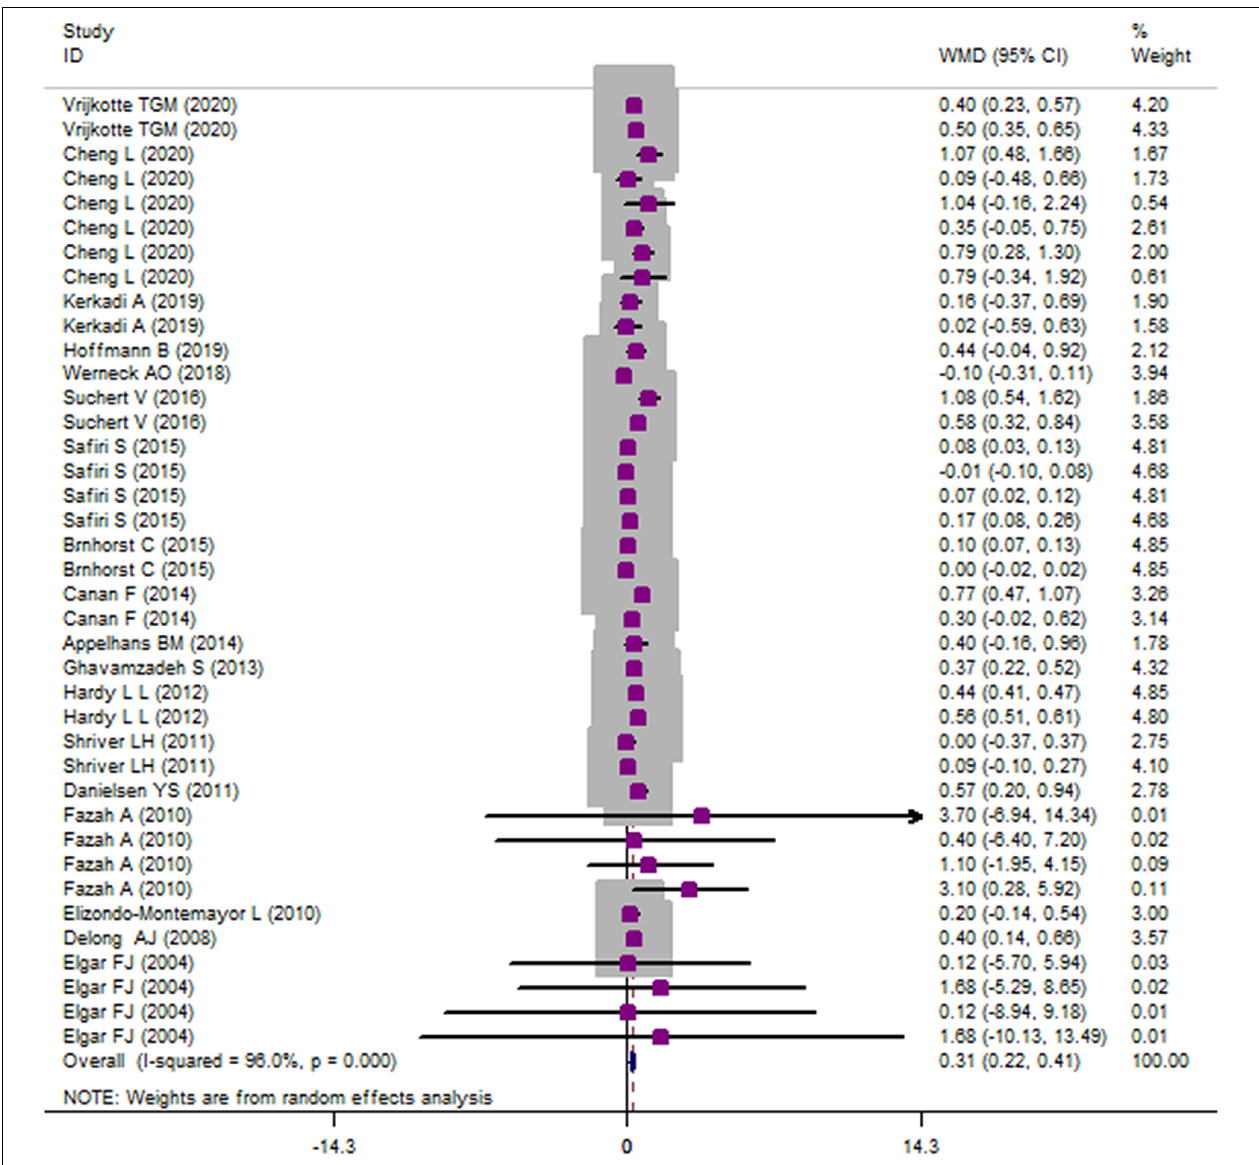
FIGURE 3 | Weighted mean difference (WMD) with 95% confidence interval (CI) of screen time in children and adolescents with obesity vs. children and adolescents without obesity. I 2 represents the degree of